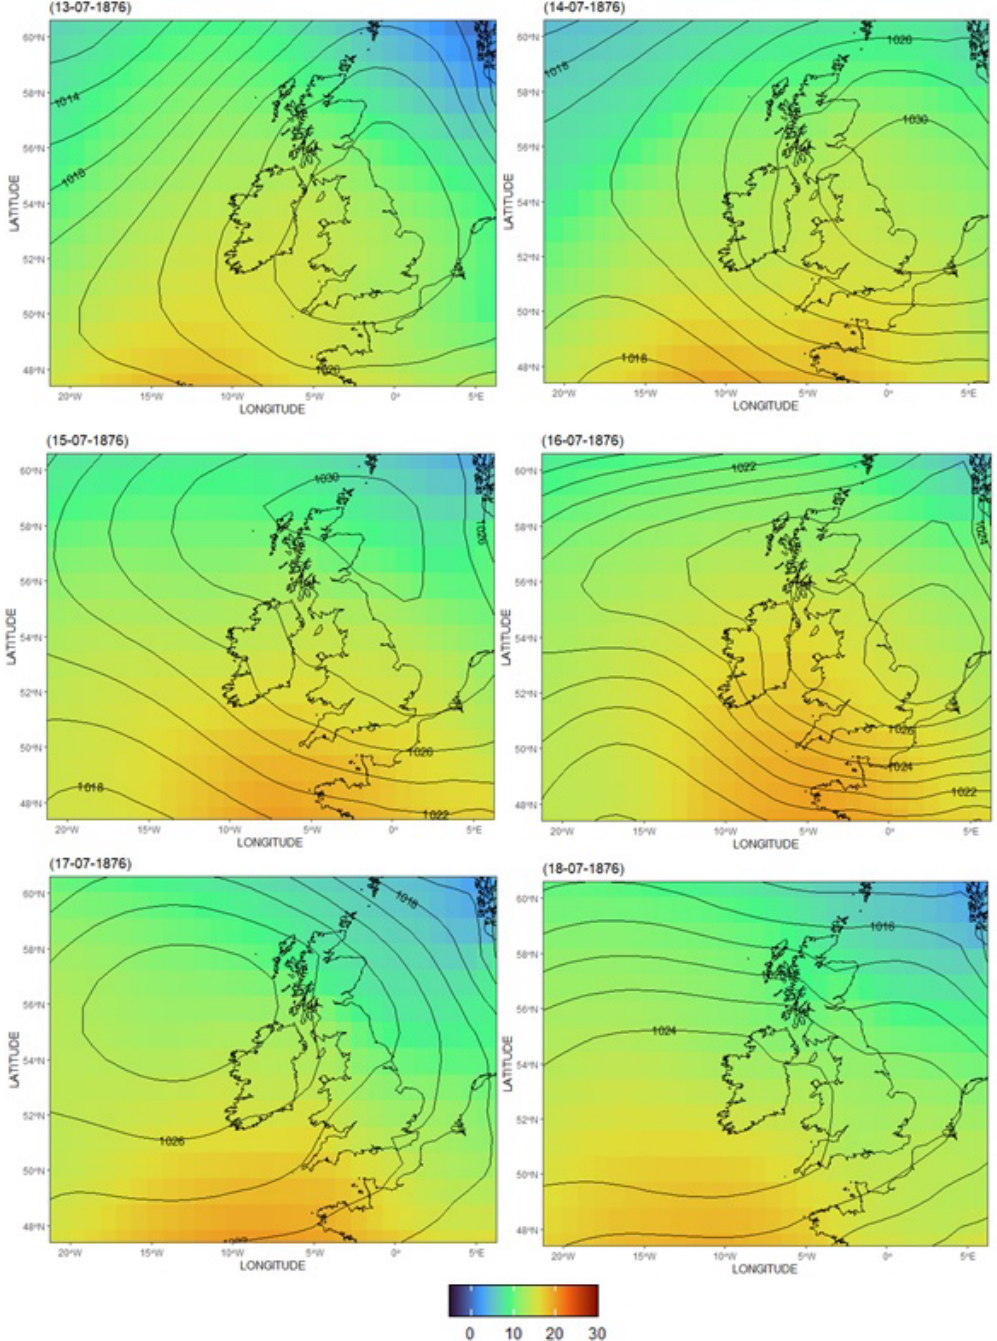
Figure 10. As Fig. 9 but for zoomed-in data for the British and Irish isles.